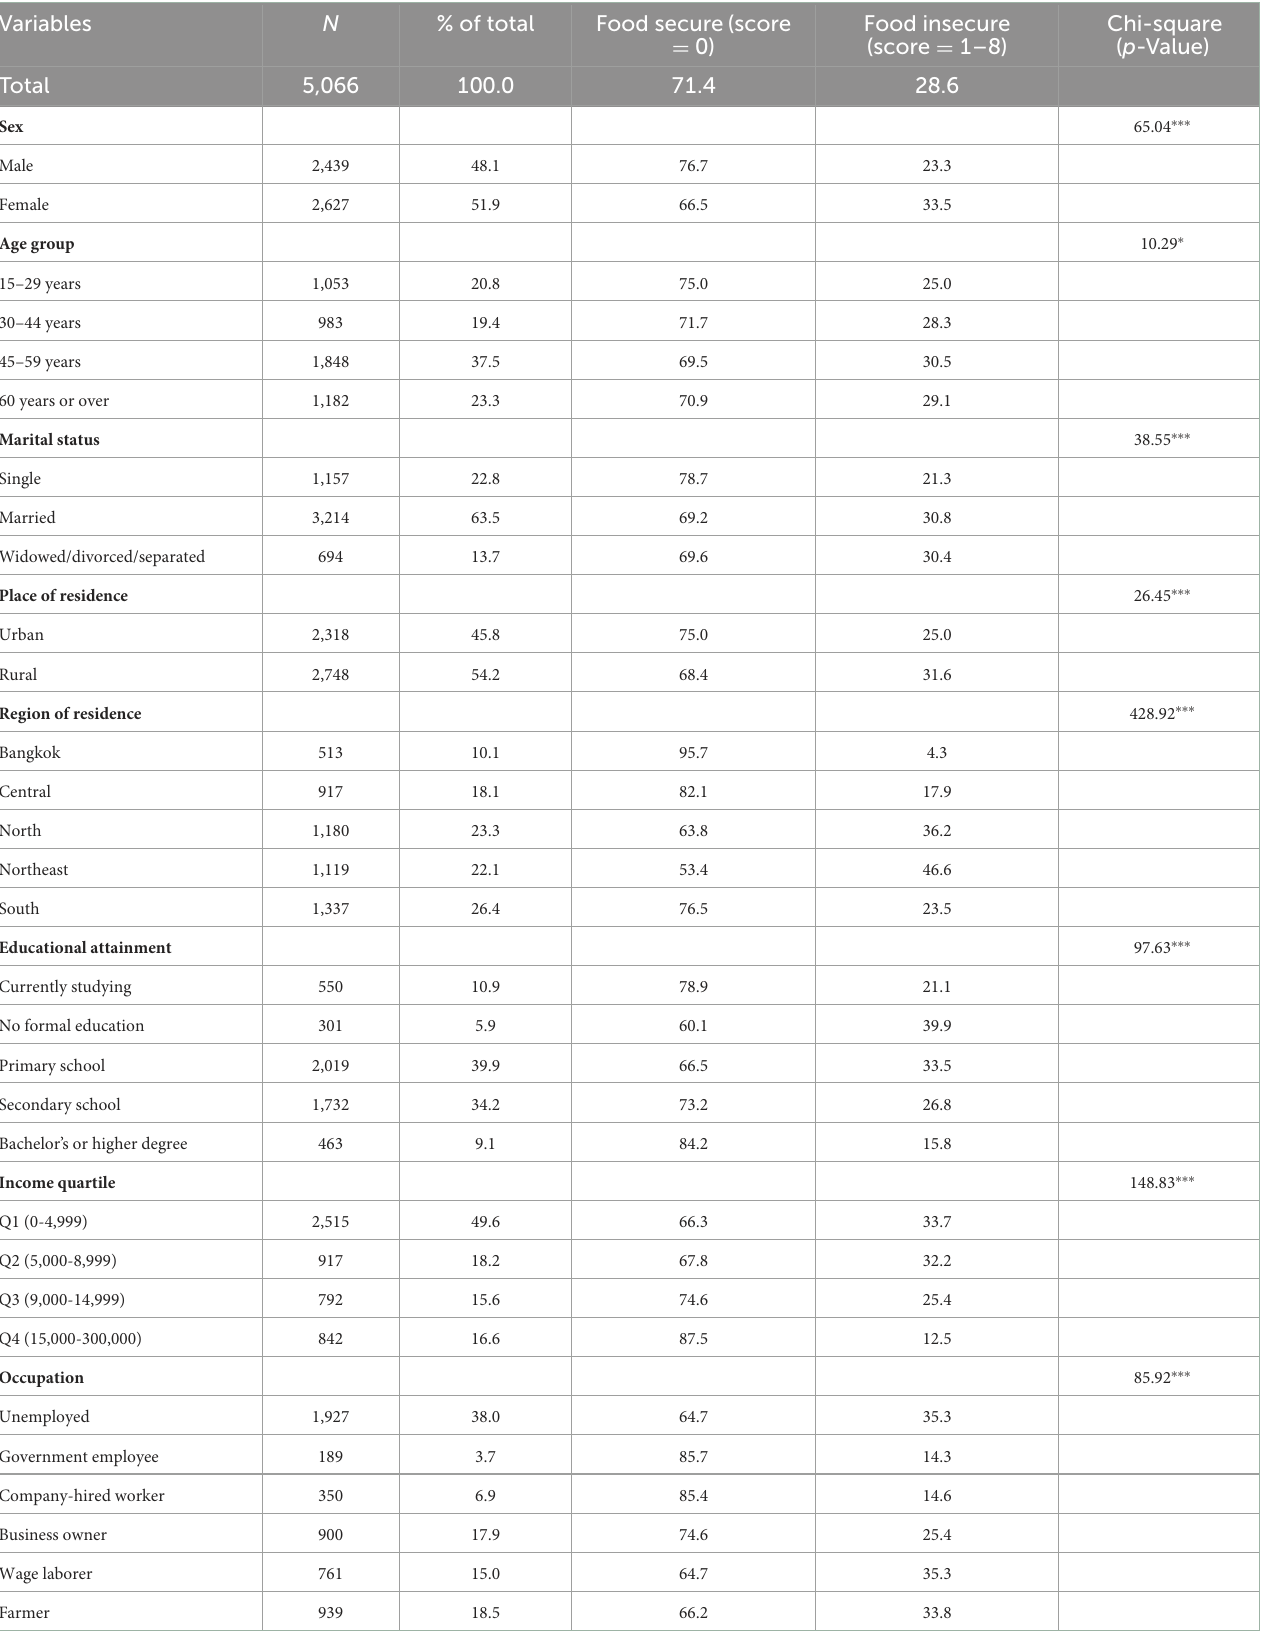
TABLE 2 Characteristics of the sample by prevalence of food security/insecurity ( N =